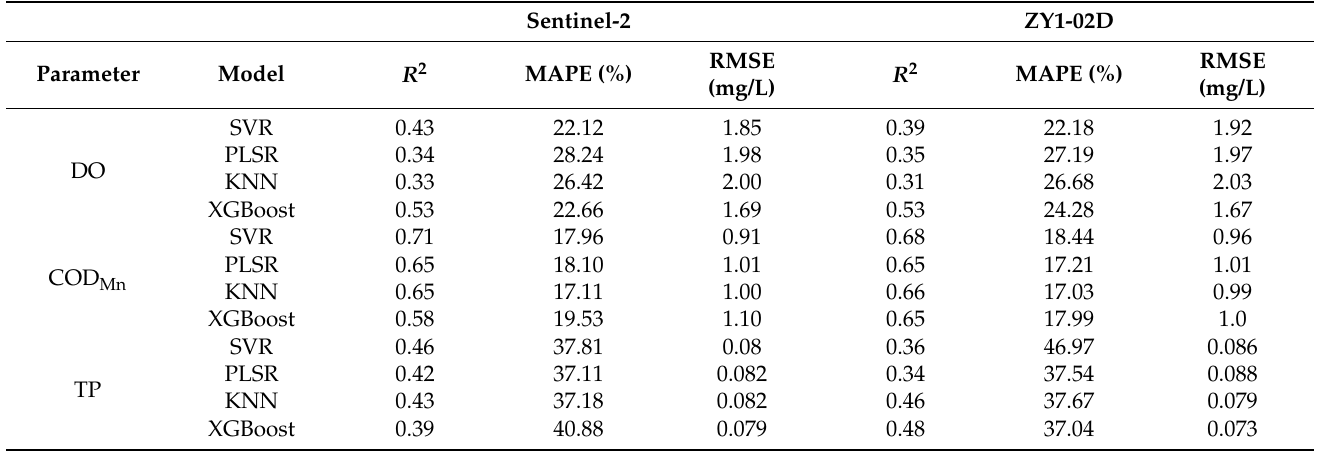
Figure 10. Performance evaluation of TP retrievals using the SVR for Sentinel-2 ( a ) and the XGBoost for ZY1-02D ( b ). Table 5. Performance of all machine learning models. Table 6. Performance of all machine learning models.